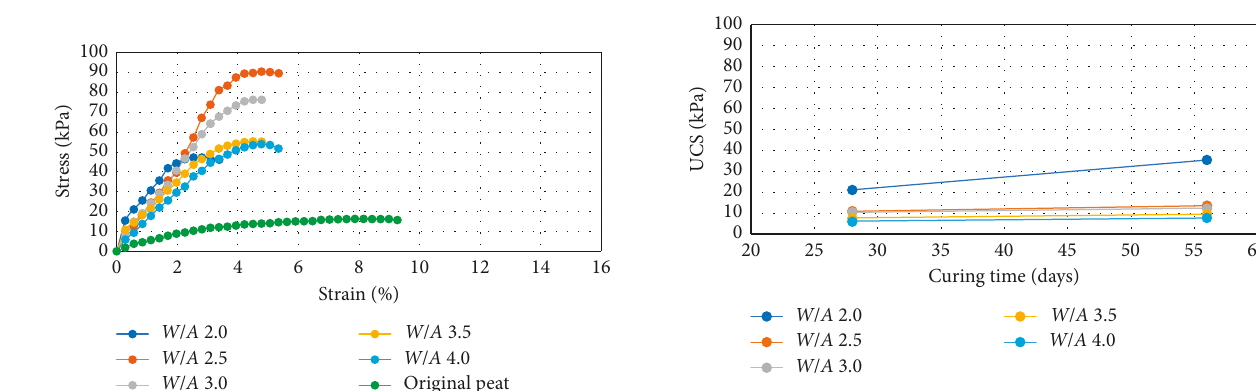
Figure 8: UCS value vs. curing time for peat B specimens ( w 803%). (cid:31)